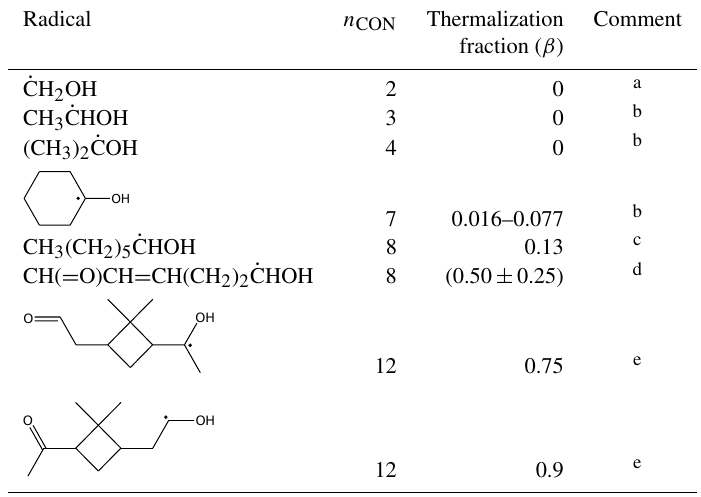
Table 16. Reported fractional formation of thermalized α -hydroxy peroxy radicals ( β ) from the reactions of α -hydroxy radicals with O 2 . Radical n CON Thermalization Comment fraction ( β